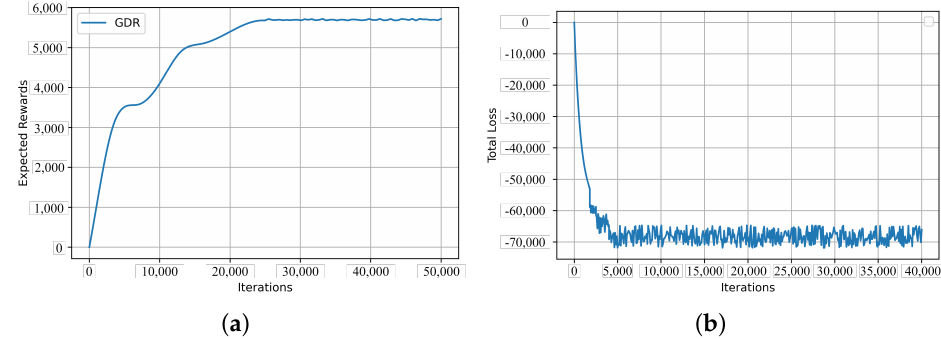
Figure 8. The convergence process and training loss. ( a ) The convergence process. ( b ) The training